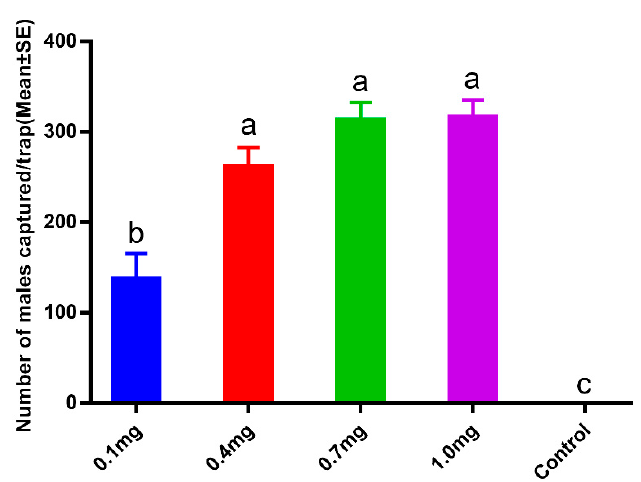
Figure 3. Trap catches of Ectropis grisescens male moths with different sex pheromone dosage. Bars mean standard error. Different letters indicate significant difference (Tukey’s HSD test, p < 0.05).